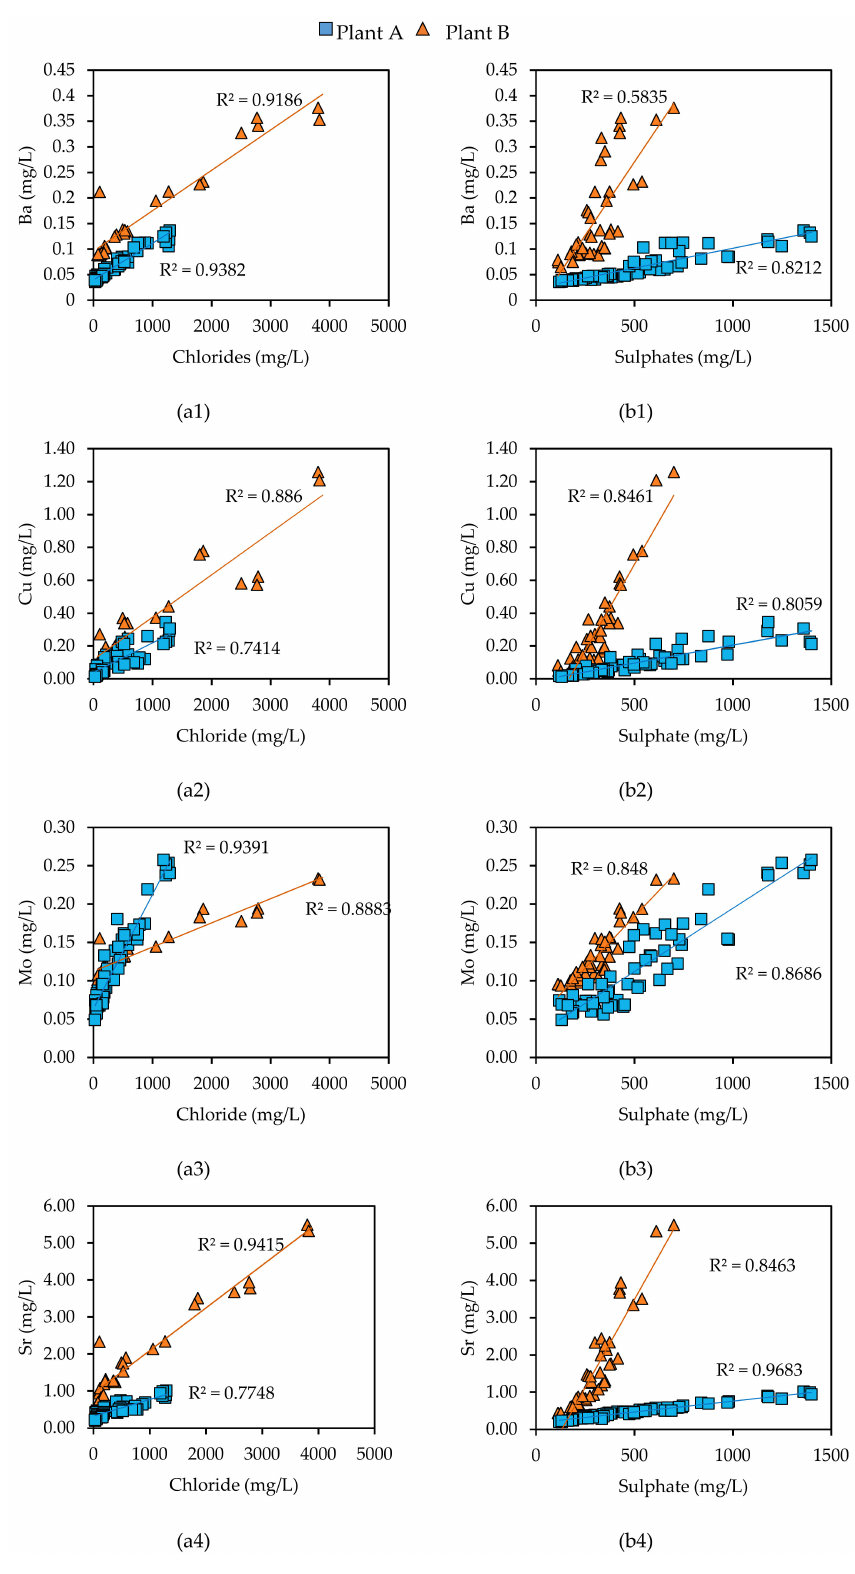
Figure 7. Correlations between chlorides ( a1 – a4 ) and sulphates ( b1 – b4 ) and Ba, Cu, Mo, and Sr in the leachates derived from the column leaching